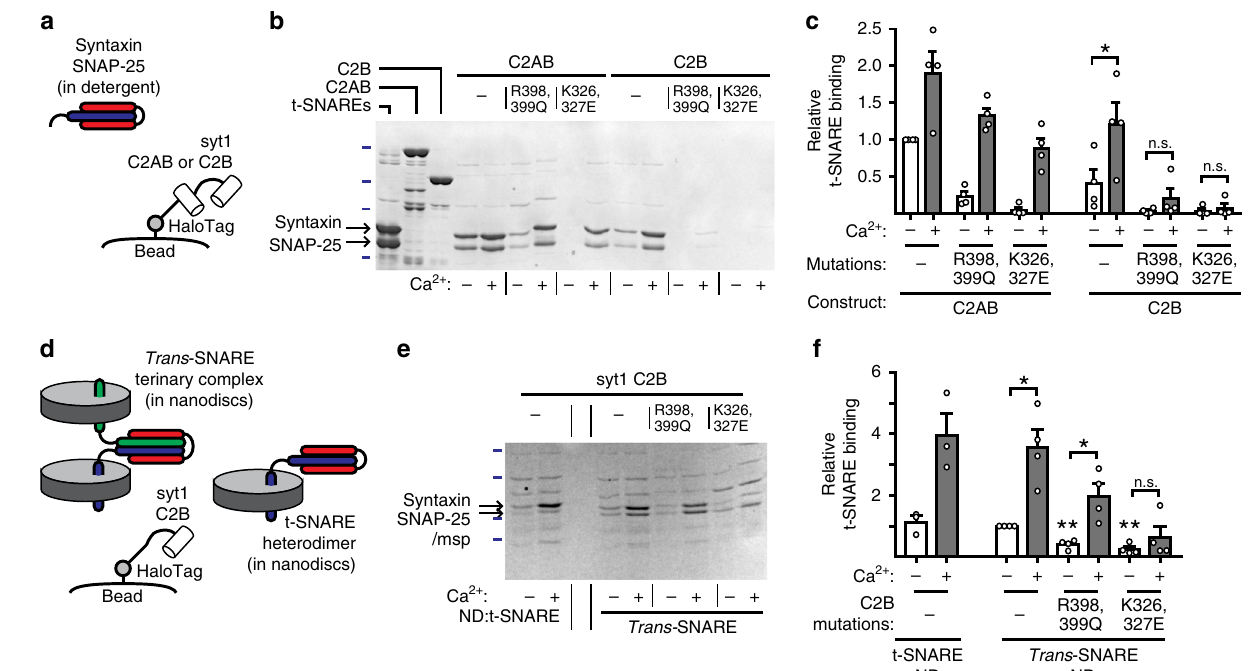
Fig. 6 SNARE-binding activity correlates with the potent fusion clamp activity of C2B. a Soluble syt1C2AB or C2B was tagged with HALO, puri fi ed from bacteria, and conjugated to HALO resin beads. These beads were then used to pull-down full-length t-SNARE heterodimers. b , c Example gel ( b ), stained by Coomassie blue, with quanti fi cation ( c ) of the ability of each mutant construct to interact with t-SNARE heterodimers. Ladder marks (blue) indicated 25, 37, 50, and 75 kD standards. d HALO-tagged C2B, conjugated to beads, was used to pull-down trans -SNARE complexes or NDs bearing t-SNARE heterodimers. e , f Example gel ( e ), stained by Coomassie blue, with quanti fi cation ( f ) of the ability of each mutant to interact with the trans -SNARE complex. Ladder marks (blue) indicated 20, 25, 37, and 50 kD standards. Error bars represent